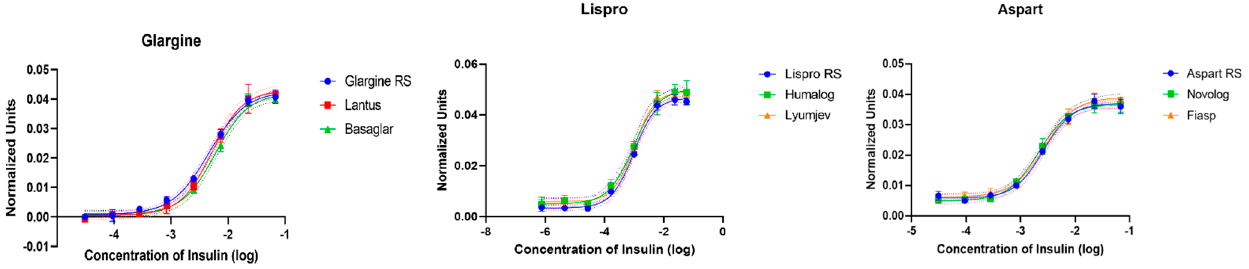
Figure 4. S-shape sigmoidal curves obtained after 4PL modeling. Normalized data are used to generate 4PL dose-response curves for the US reference standards and the different insulin samples. “RS” refers to USP reference standards.